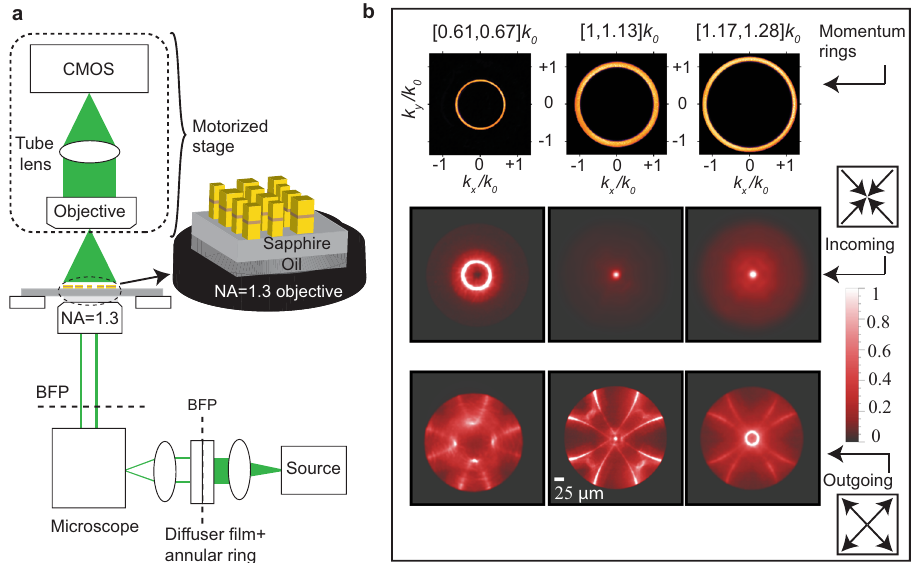
Fig. 3 Understanding luminescent metalens functionality through structured illumination. a The measurement setup used to characterize the focusing performance of the metalenses in transmission, once the excitation is a monochromatic, oblique plane wave at a wavelength of 560 nm. b Metalenses are illuminated with three different momentum-space rings: 0 : 61 k 0 < k jj i of metalenses designed to have a focal length of f ¼ 150 μ m are shown under illumination with these three momentum rings, for both the “ incoming ” and “ outgoing ” metalens designs. The “ incoming ” and “ outgoing ” sketches and their accompanying arrows show the direction of the traveling waves on the surface of the metalens with respect to the center of the